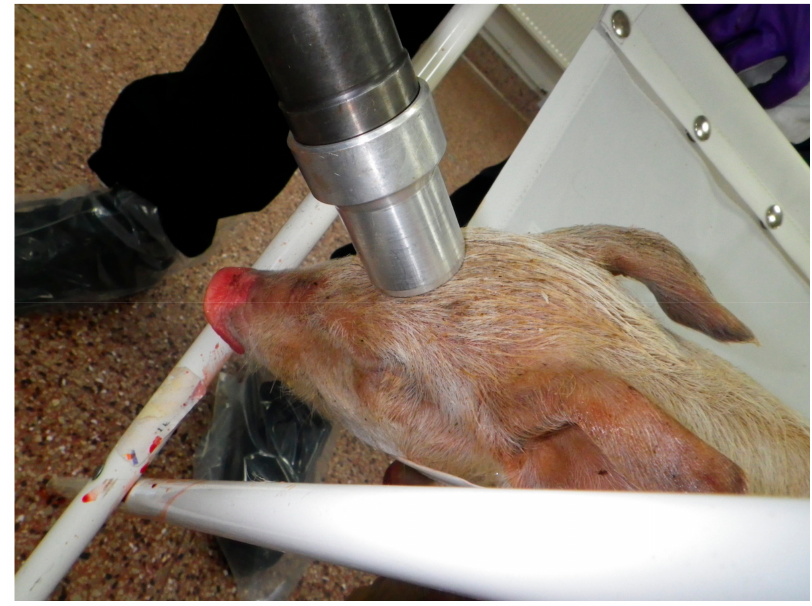
Figure 5. Shooting position for piglets on the midline on the frontal/parietal